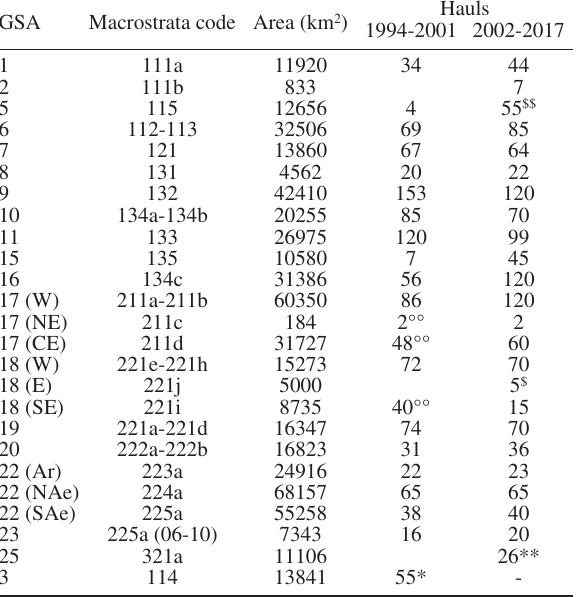
Table 1. – Average number of hauls carried out during the MEDITS bottom trawl surveys by each geographical sub-area (GSA) estab- lished by the General Fisheries Commission for the Mediterranean during the period 1994-2001 (before the DCF) and the period 2002- 2017. The codes of the MEDITS macrostrata (see Fig. 3) and the relative areas in km 2 are also